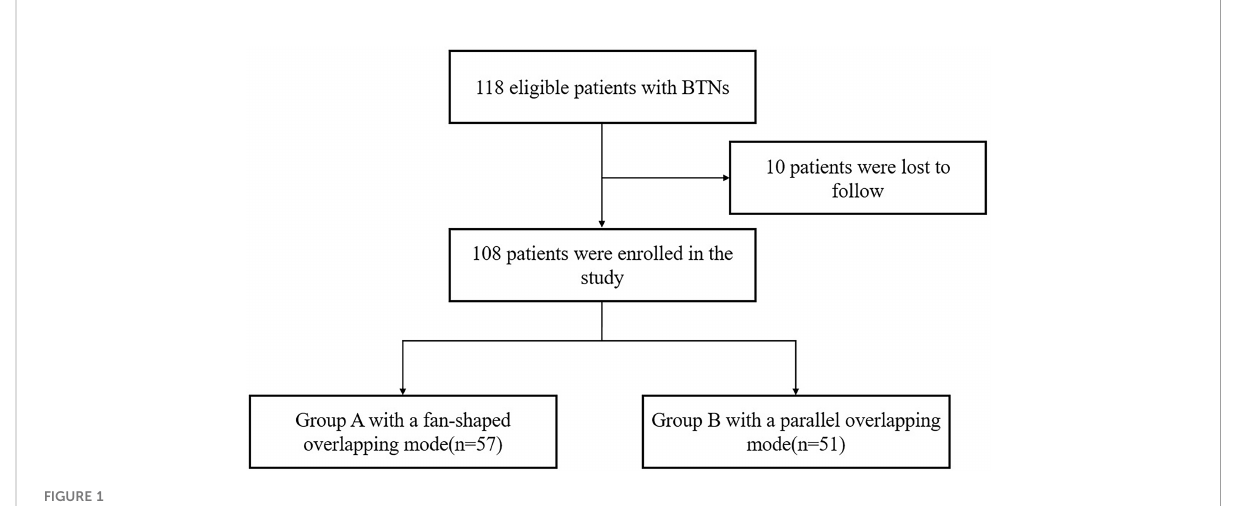
FIGURE 1 Patient enrollment process. BTN, benign thyroid